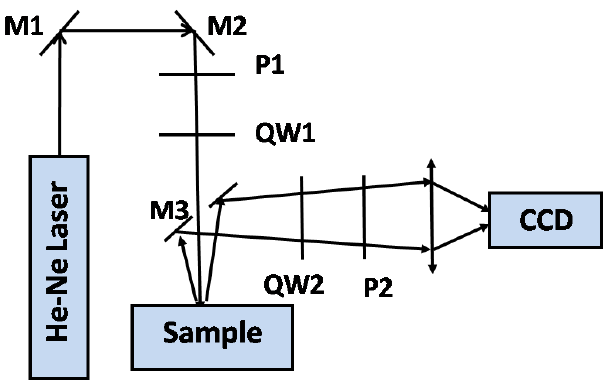
Fig. 2. A schematic of the experimental setup. P, polarizer; QW, quarter-wave plate; CCD, imaging